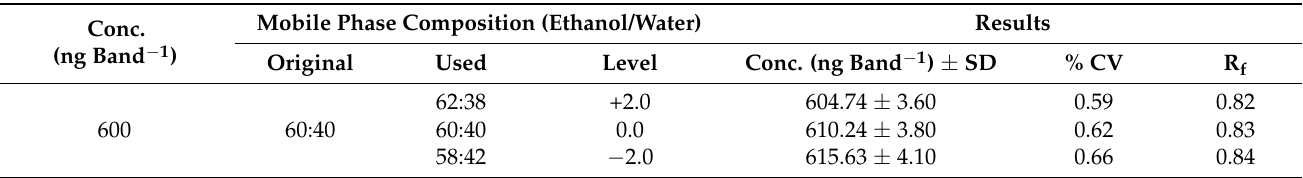
Table 5. Results of robustness analysis for HDQ for ecologically sustainable HPTLC method (mean ± SD; n = 6). Conc.